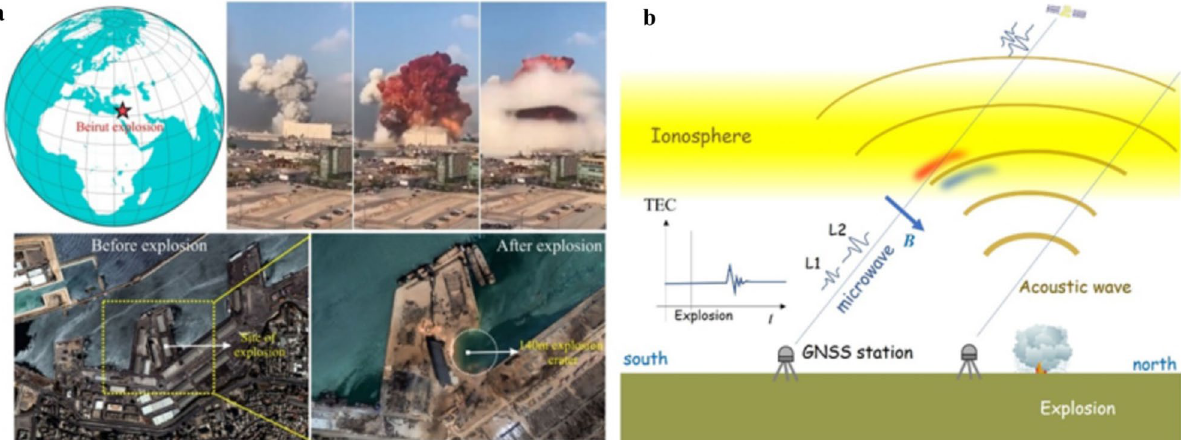
Figure 1. The 2020 Beirut explosion and ionospheric disturbance. ( a ) Location of August 4, 2020 Beirut explosion point marked by a red star in the globe. Sequence of the ash cloud captured during the explosion (snaps archived at https ://www.thene wsmin ute.com/artic le/shock ing-video s-show-power ful-explo sion-rocks -leban on-capit al-beiru t-13004 1). SkySat imagery before and after the explosion shows the impact of explosion in Beirut (imagery captured on May 31, 2020 and on August 5, 2020) (archived at the largest earth-observation- satellite-network of global dataset platform at https ://www.thegu ardia n.com/world /2020/aug/06/beiru t-explo sion-befor e-and-after -satel lite-image s). ( b ) Illustration of ionospheric disturbance caused by an explosion can be detected by differential ionospheric delays of microwave signals of two carrier frequencies from GNSS